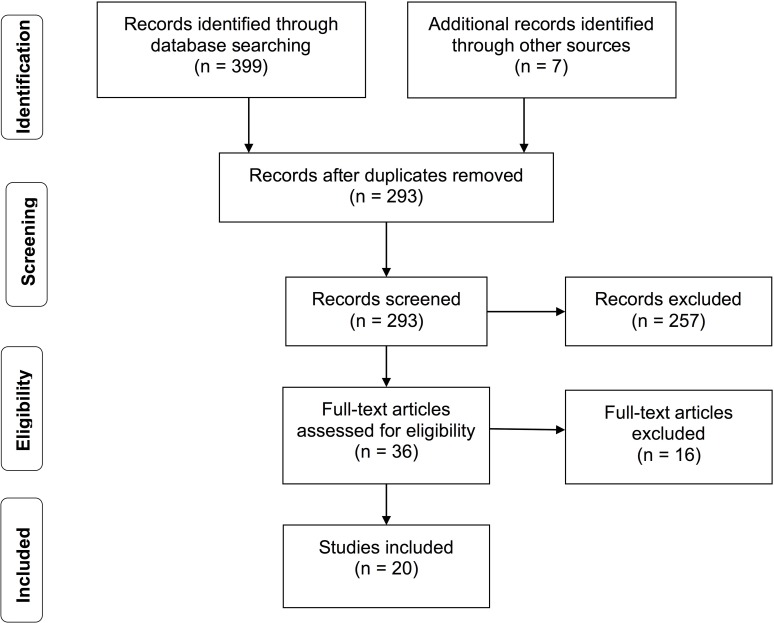
Study flow diagram.